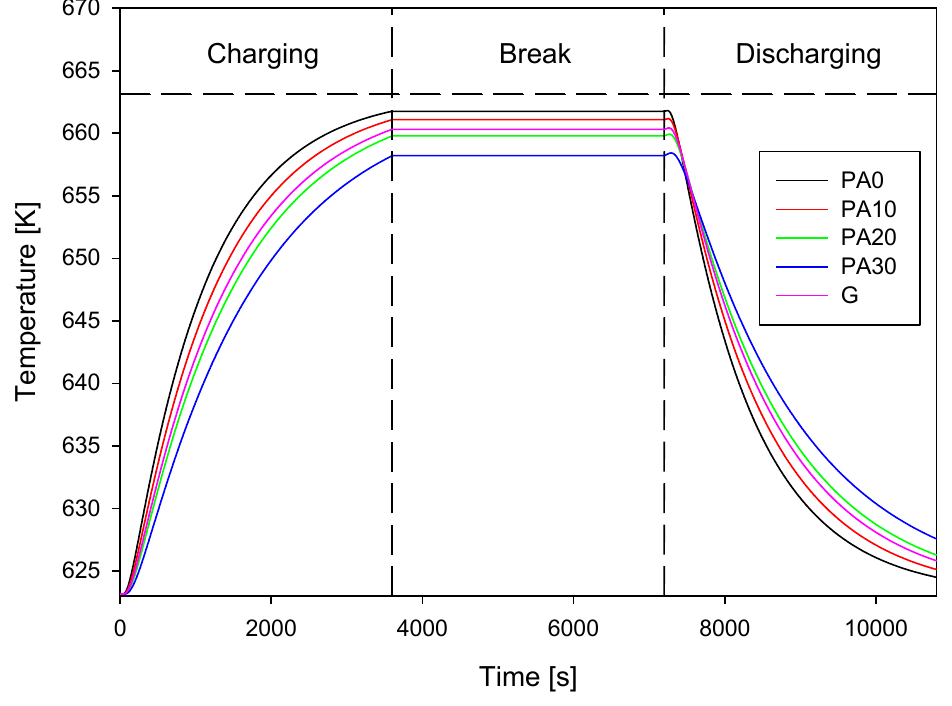
/2 for developed materials, constant V a